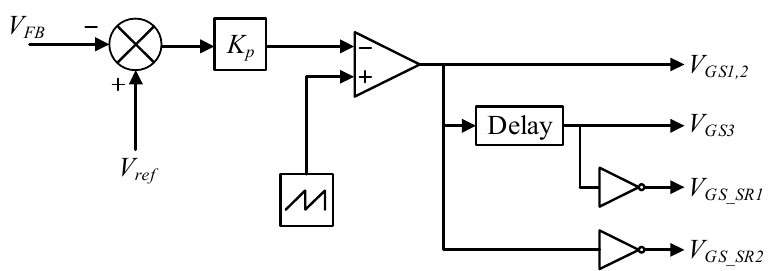
Figure 24. A diagram of the proposed control scheme.